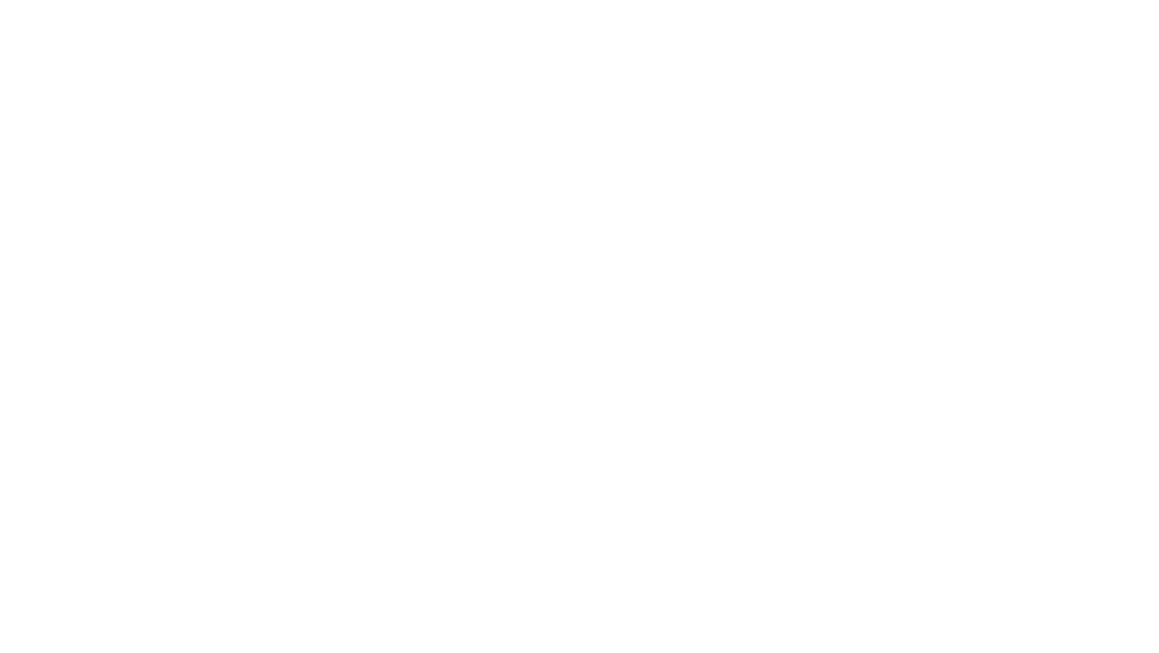
PLOS ONE | https://doi.org/10.1371/journal.pone.0267099 April 28,